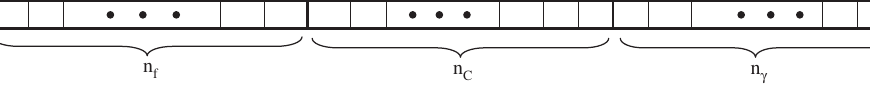
Figure 2. Chromosome